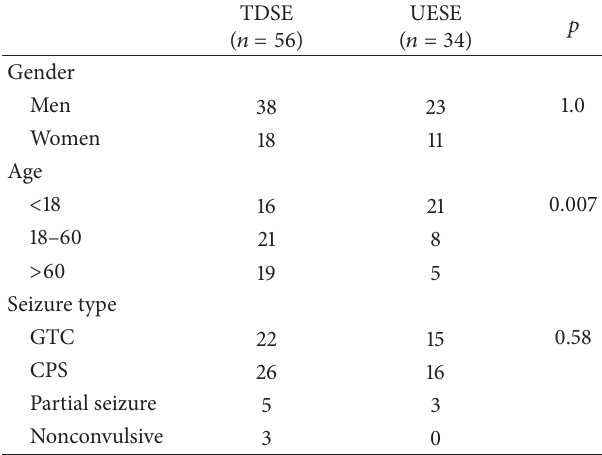
Table 4: Duration of seizure in patients’ first seizure and epilepsy.